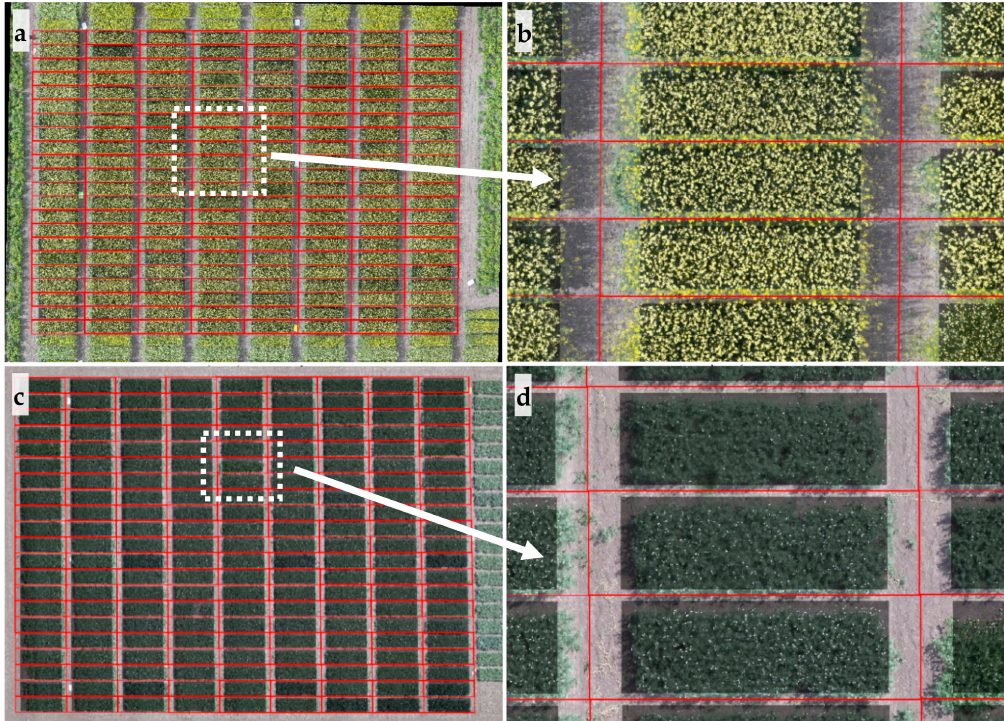
Figure 4. Results of flower extraction from aerial images of spring canola and pea. Separated individual plots for spring canola and pea are outlined by red rectangles as shown in ( a ) and ( c ), respectively; regions of interest (plot with four edges removed) were dimmed while flowers were highlighted in white as shown in ( b ) and ( d ); ( b ) and ( d ) are zoom-in images of white-highlighted areas of ( a ) and ( c ),